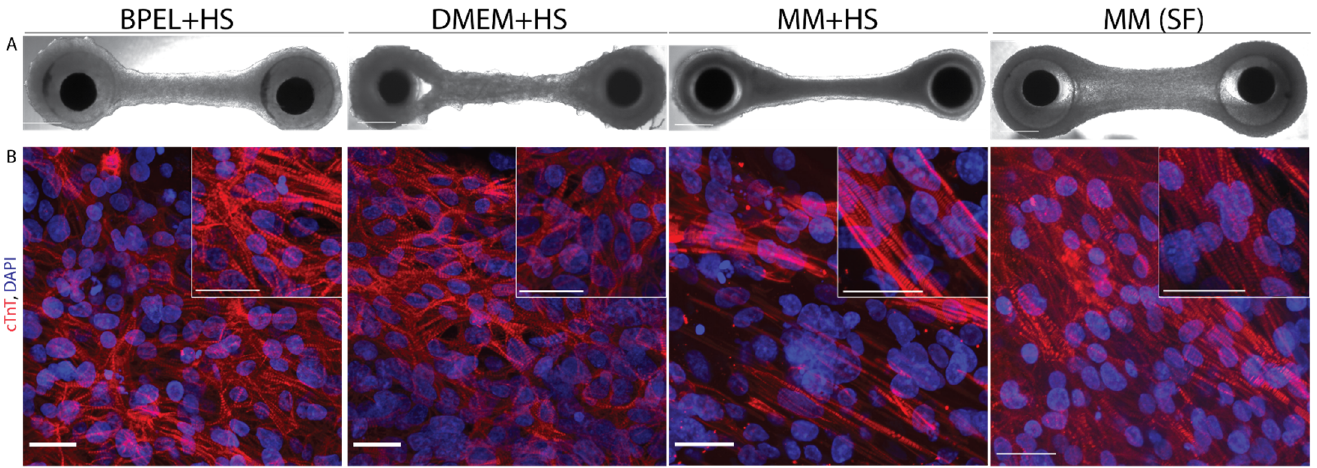
Figure 6. Morphological analysis of EHTs in four different media at day 21 of culture. ( A ) Brightfield images of full EHTs in BPEL+HS, DMEM+HS, MM+HS, or MM(SF). Scale bar = 0.5 mm. ( B ) Confocal images of whole-mount tissue im- munostaining for cardiac troponin T (cTnT, red) counterstained with DAPI (nuclei, blue). Scale bars, 25 µm. HS, horse serum and SF,